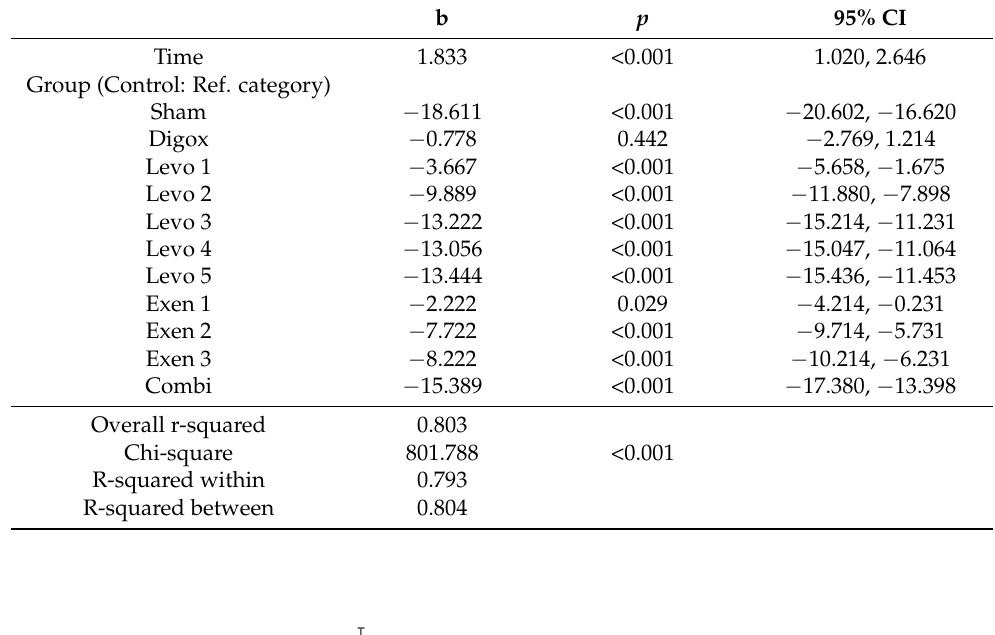
Table 12. Longitudinal analysis for CK-MB for all groups.